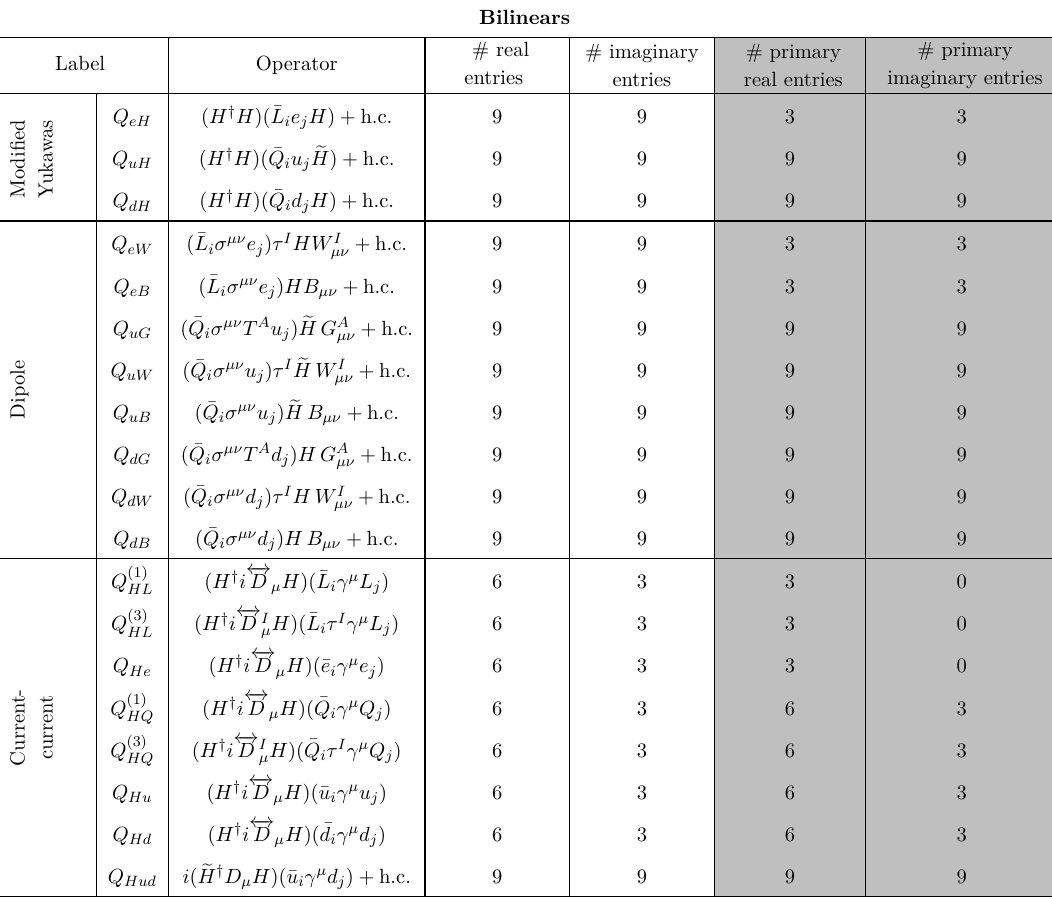
Table 7 . The list of dimension-6 fermionic bilinear operators of SMEFT, as given in ref. [37], together with the number of real and imaginary entries they each contain, as well as the number of primary parameters (highlighted in gray, see the text for more details). When + h.c. is specified, the hermitian conjugate of the operator must be included, too. We indicate with i, j, k, l the flavor indices and with a, b indices in the fundamental of SU(2) L . T A , A = 1 , . . . , 8 are the generators of the gauge SU(3) c , while τ I = σ I , I = 1 , 2 , 3 are the generators of SU(2) L , with σ I the Pauli 2